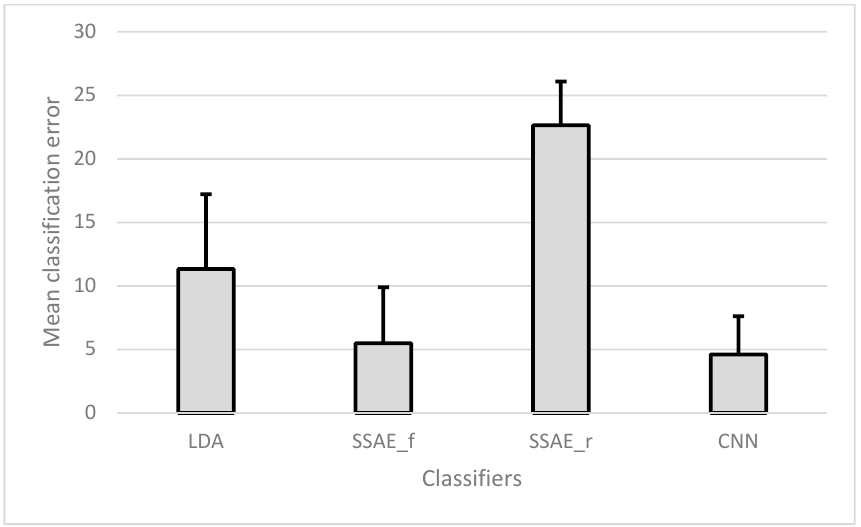
Figure 7. Mean (and SD) classification error of all classifiers for between-days analysis with 15-fold cross-validation.